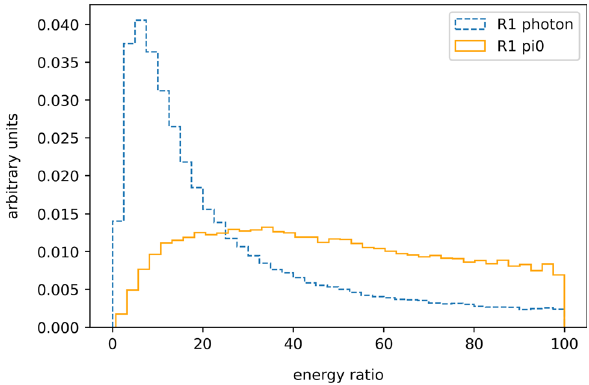
lapping digits, it is however a resolved π 0 . The two photons are not separable, it is a merged π 0 and is reconstructed as a single cluster bigger than 3 × 3